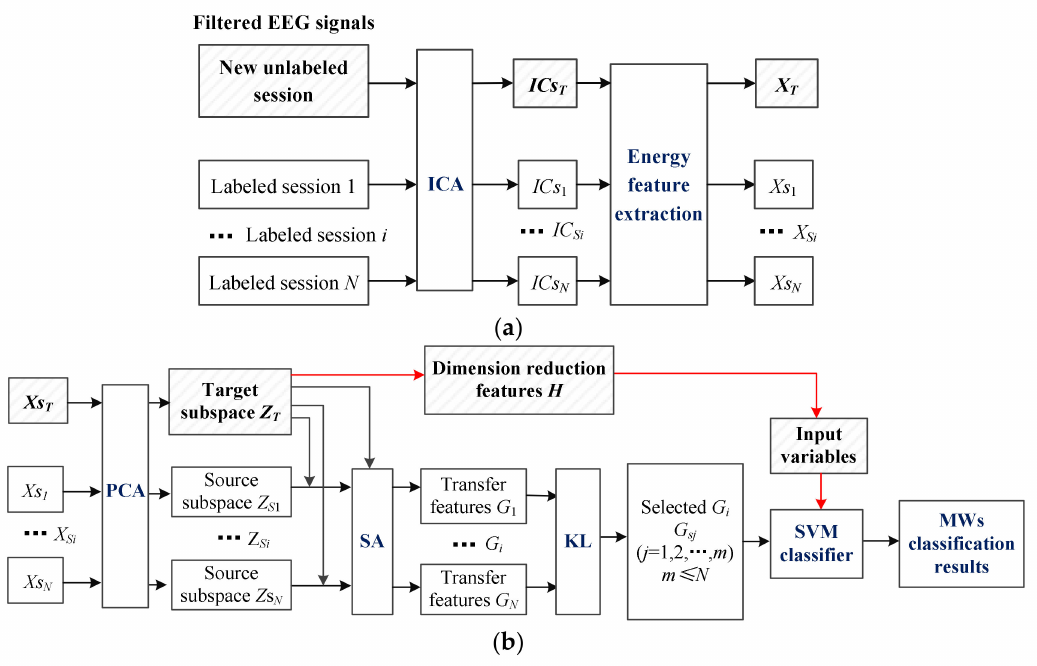
Figure 4. SA method; ( a ) Independent Components (ICs) of EEG and energy feature extraction; ( b ) Cross-Session Subspace Alignment (CSSA)